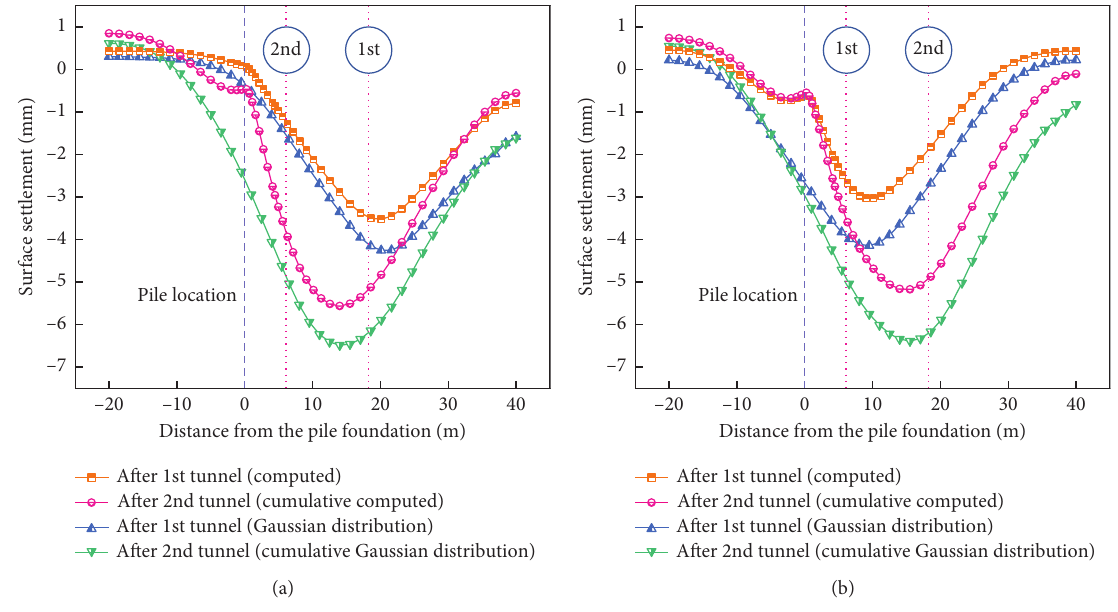
Figure 10: Ground surface settlement trough at pile location. (a) Condition (a). (b) Condition (b).